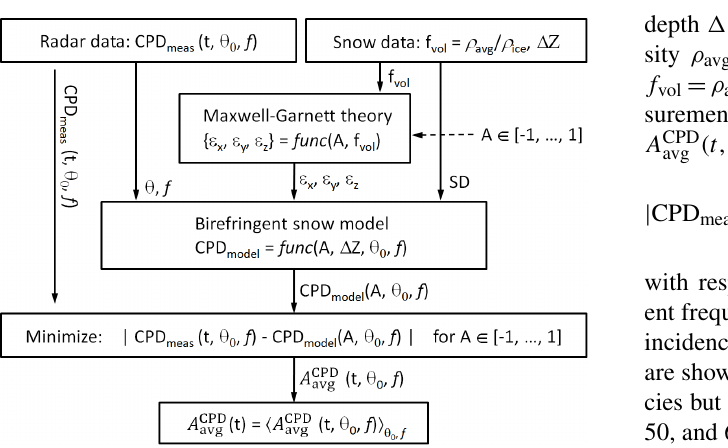
Figure 10. Processing chain used to estimate the average anisotropy of the snowpack, A CPD avg . The anisotropy can be estimated from the measured CPD, by minimizing the difference between modeled and measured data with respect to A when snow depth (cid:49)Z and the ice volume fraction f vol are known. The anisotropy A CPD avg (t , θ 0 , f ) was calculated independently for all incidence angles, θ 0 , and frequen- cies, f , and the results were averaged to obtain A CPD avg (t)